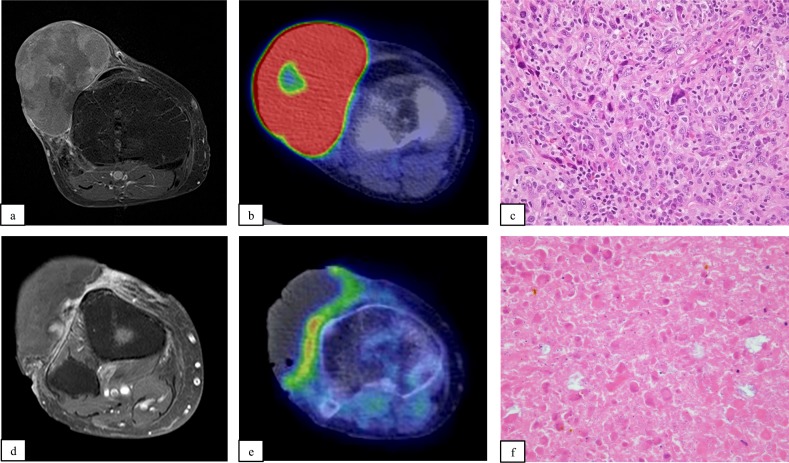
A typical patient treated with RHC therapy (patient no. 10).